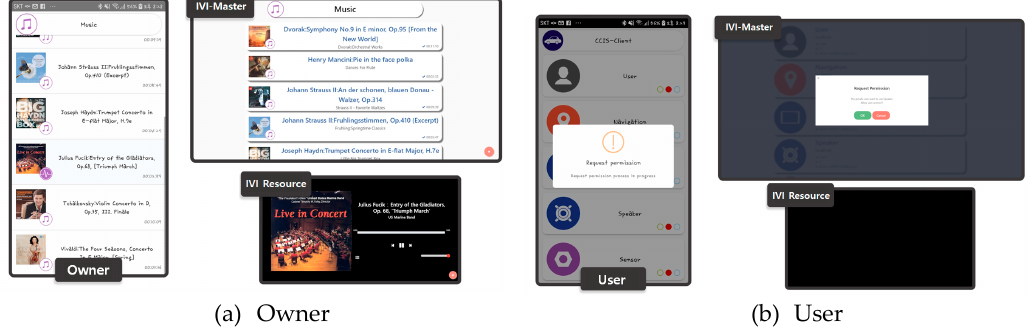
Figure 17. Screen captures for shared resource control by owner and user.